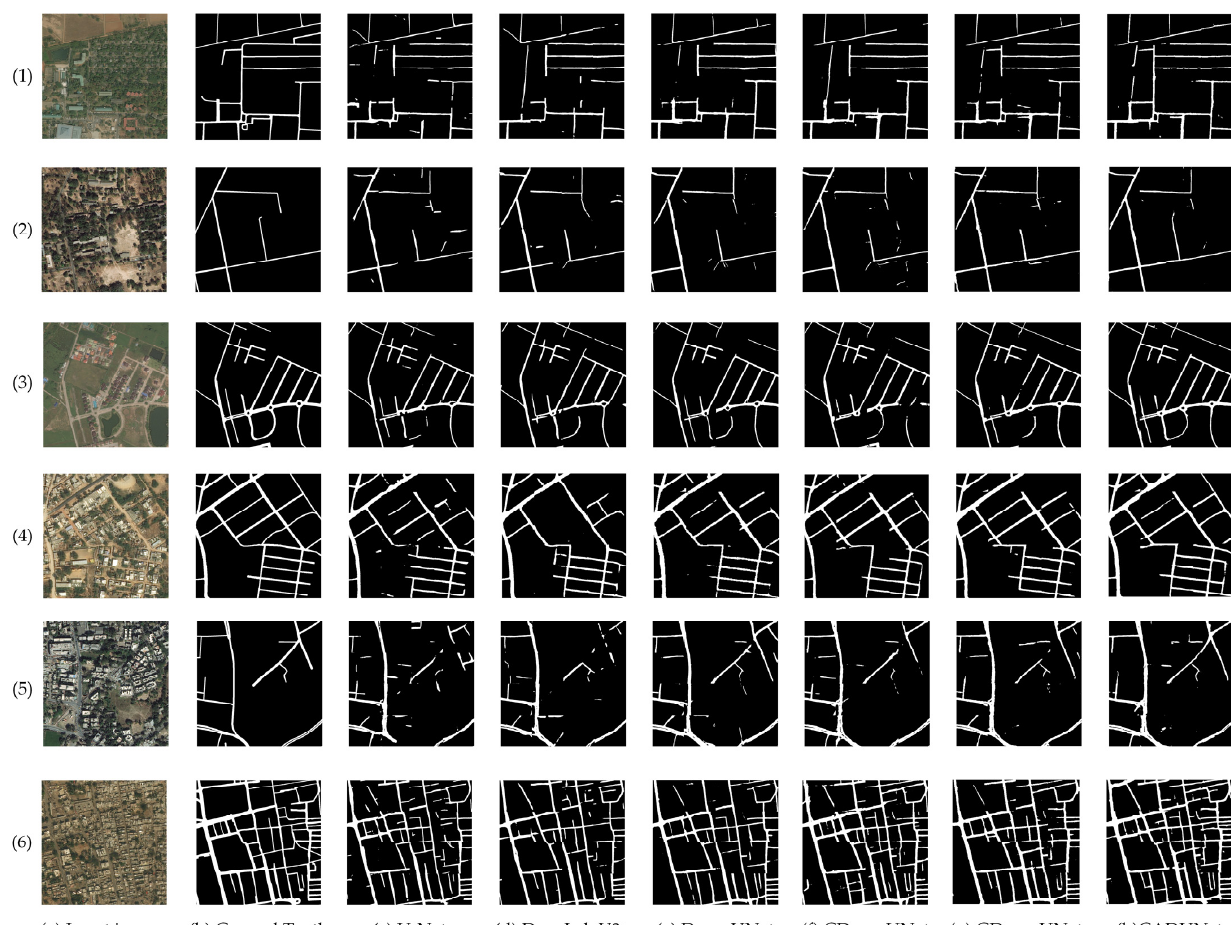
Figure 9. Connectivity of the road networks extracted from the CVPR roads dataset. ( 1–3 ) The rural roads; ( 4,5 ) The sub- urban roads; ( 6 ) The urban